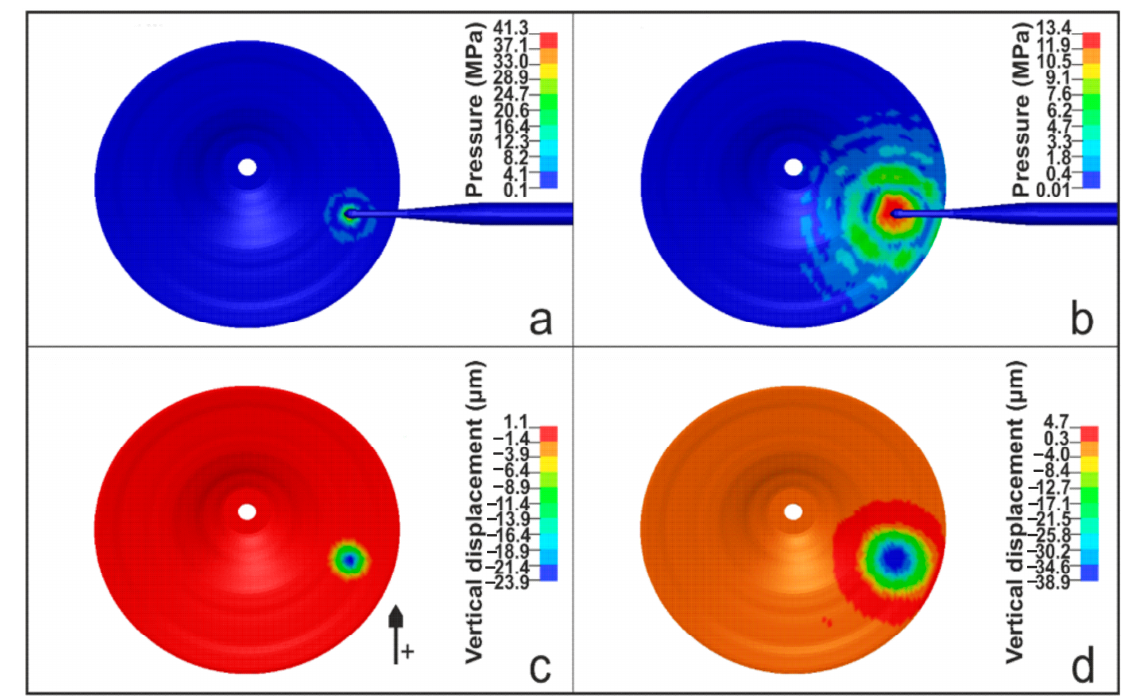
Figure 4. Pressure distribution of the cymbal at ( a ) 0.1 ms and ( b ) 0.3 ms after the drumstick hits the instrument for the mf stoke. Vertical displacement of the cymbal at ( c ) 0.1 ms and ( d ) 0.3 ms after the drumstick hits the instrument for the mf stroke. The arrow denotes the positive direction of dis- placements.